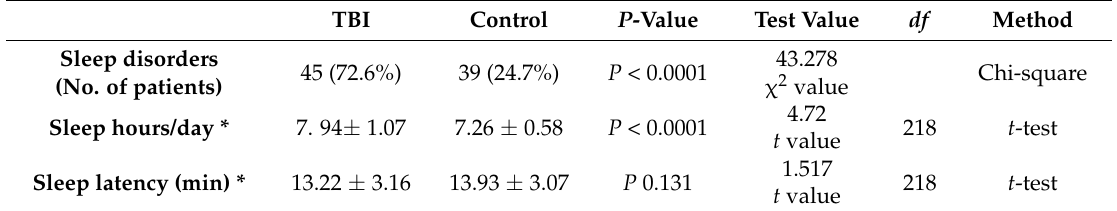
Table 3. Data for traumatic brain injury (TBI) and the control groups.